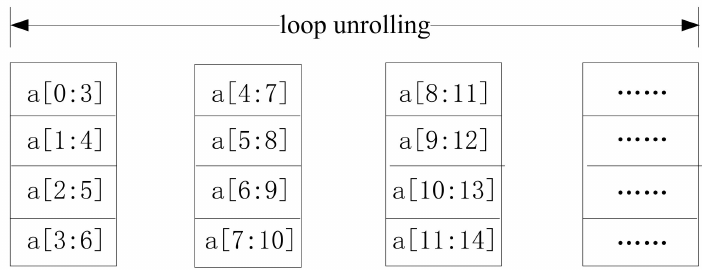
Figure 2. The unrolling factor is set to 4 for program transformation.